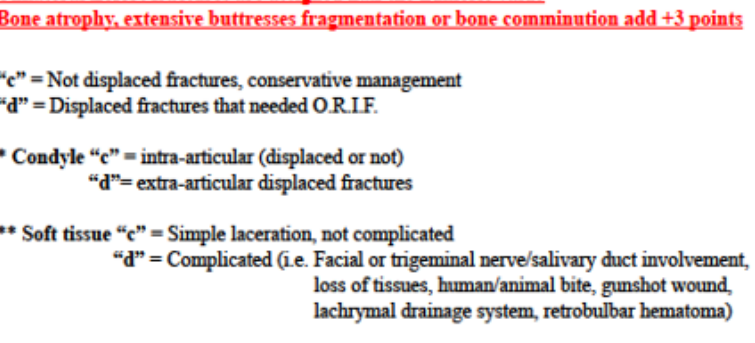
Figure 1. The CFI scale for estimating the severity of facial trauma. NOE = Naso-Orbito-Ethmoid fractures; ORIF = Open Reduction and Internal Fixation (Reprinted with permission from Ref. [2]. Copyright 2019 Elsevier).